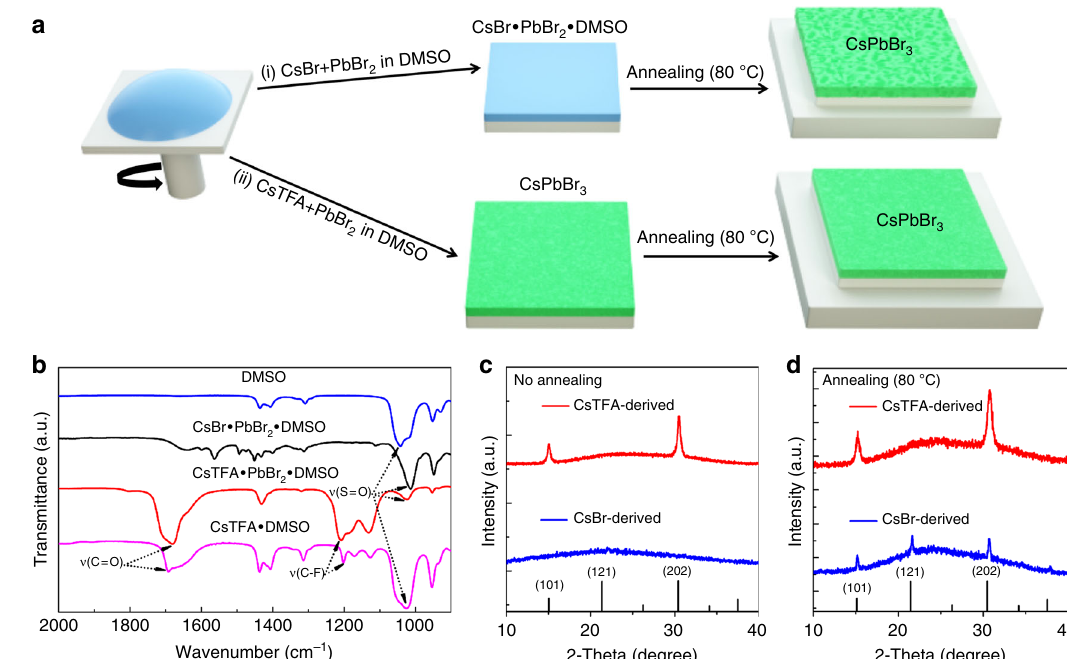
Fig. 1 FTIR and XRD study of the CsBr- and CsTFA-derived CsPbBr 3 perovskites. a Schematic presentation of the fi lm fabrication procedure. Route (i) employs commonly used precursors CsBr and PbBr 2 , while the route (ii) employs CsTFA in place of CsBr. b FTIR of DMSO (liquid), CsBr (cid:129) PbBr 2 (cid:129) DMSO (powder), CsTFA (cid:129) PbBr 2 (cid:129) DMSO (powder), and CsTFA (cid:129) DMSO (powder). c XRD patterns of CsPbBr 3 fi lms deposited on PEDOT:PSS coated ITO glass from CsBr(1.7) and CsTFA(1.7) without annealing. d XRD patterns of CsPbBr 3 fi lms deposited on PEDOT:PSS coated ITO glass from CsBr(1.7) and